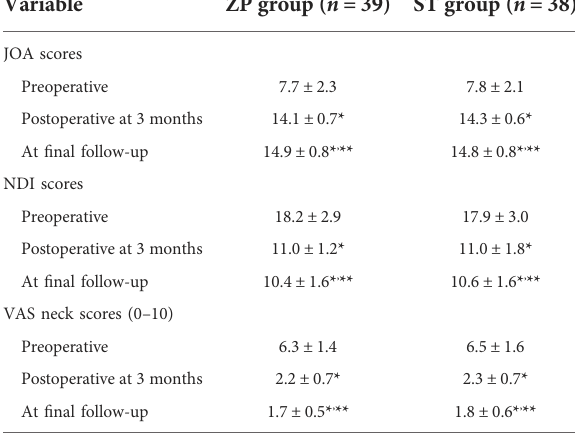
TABLE 3 Patients ’ functional